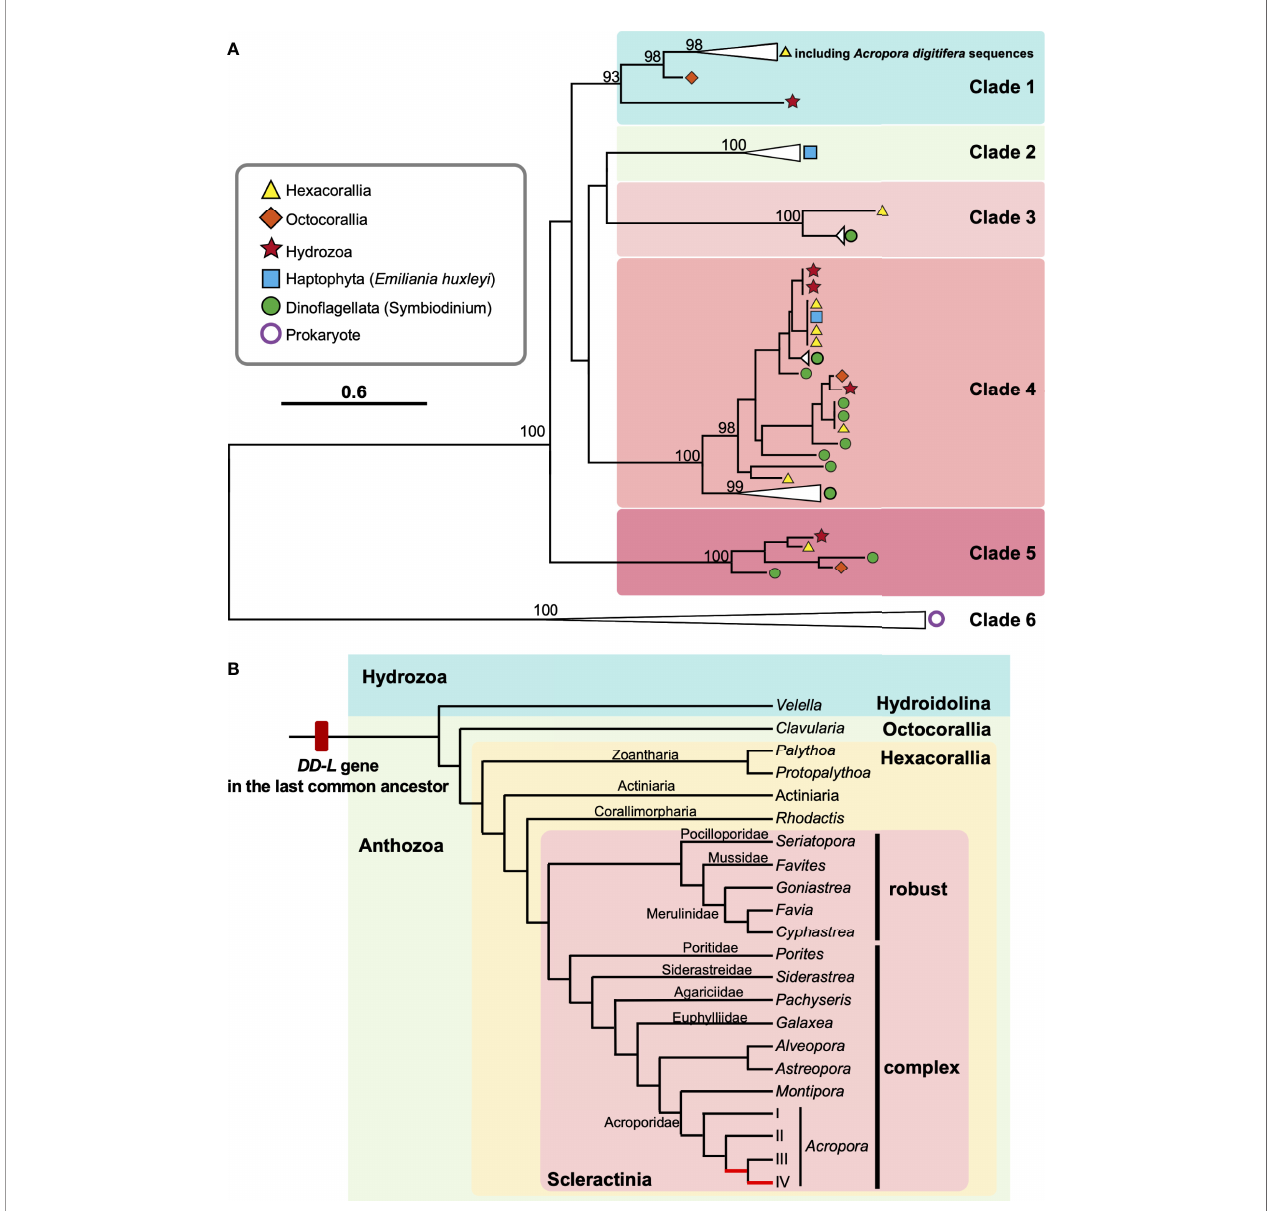
FIGURE 4 | Molecular phylogenetic analysis of DL-L genes identi fi ed from transcriptomic databases of Cnidaria. (A) Possible DL-L genes from cnidarian NCBI TSA databases were analyzed using the maximum likelihood method. 667 gap-trimmed aligned amino acids were used for phylogenetic analysis. Bootstrap support for representative nodes is shown. Clades 1-6 of DL-L genes of cnidarians, other eukaryotes and prokaryotes are highlighted in different colors. (A) digitifera DL-L genes identi fi ed from cDNA, which were all clustered in Clade 1, are also included. DL-L genes from Hexacorallia, Octocorallia, Hydrozoa, Haptophyta, Dino fl agellata, and Prokaryota are colored in yellow (triangle), orange (diamond), red (start), blue (square), green (circle), and purple (white circle), respectively. The bar indicates 0.6 substitutions per site in aligned regions. The complete phylogenetic tree is shown in Supplementary Figure 3 . (B) Updated evolutionary history of DL-L gene in the Phylum Cnidaria. Only species of cnidarians possessing animal-type DL-L genes are shown. Two Acropora -speci fi c gene expansion events proposed by Shinzato et al. (2021a) are shown in red in the phylogenetic tree. Phylogenetic relationships of cnidarians and scleractinian corals are derived from Kayal et al. (2018) and Kitahara et al.